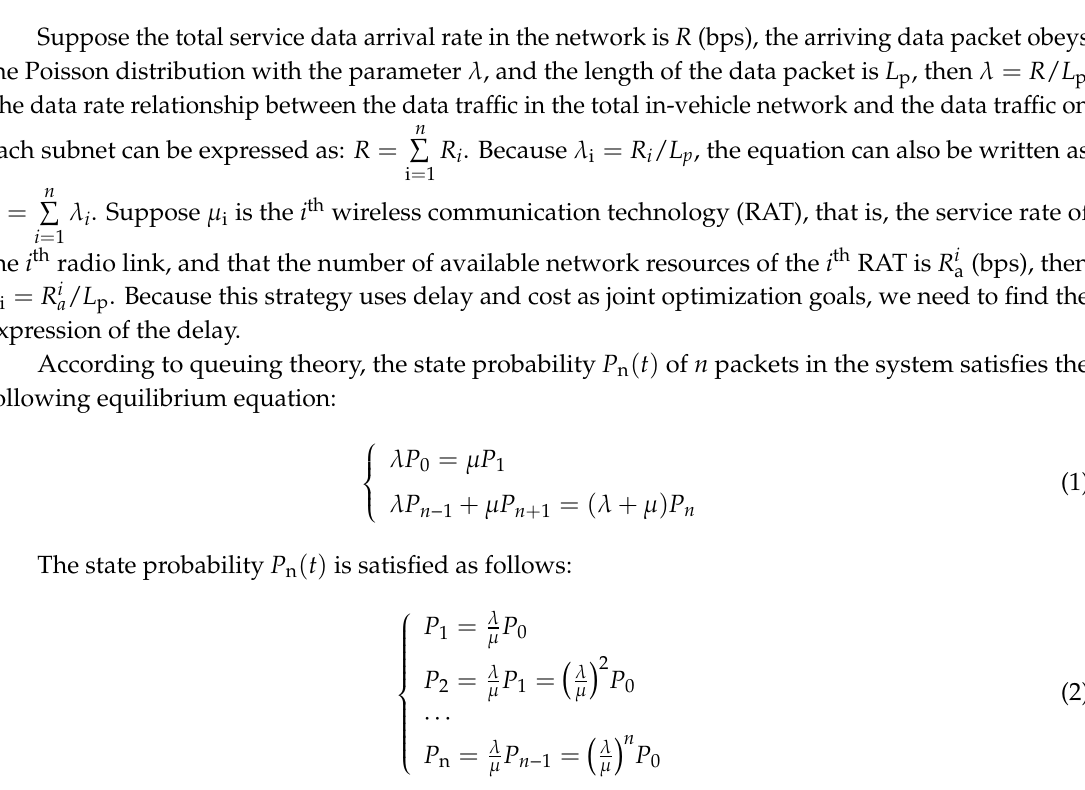
Figure 3. Multi-service distributed load sharing model.